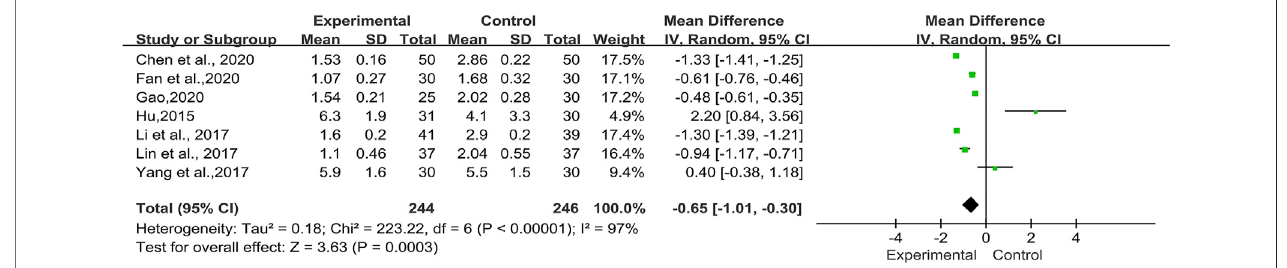
FIGURE 4 | Forest plot of HRCT integral with TwHF combined with conventional treatment versus pure conventional treatment.